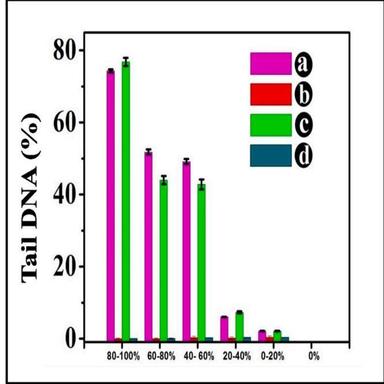
Tail DNA % in the gill cells of zebra fish for (a) P1WW; (b) P1WT; (c) P2WW; (d) P2WT samples. The error bars denote mean values � SD of three independent experiments, each performed in replicates.